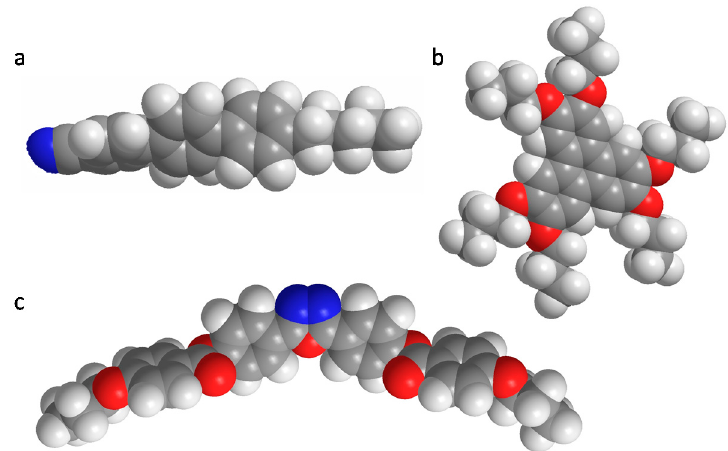
Figure 1. Spacing-filling models of archetypical mesogens: ( a ) rod-shaped terphenyl derivative; ( b ) disc-shaped triphenylene derivative; and ( c ) diphenyloxadiazole-based bent-core mesogen. Note that the aliphatic tails have been shortened for clarity. Atom color coding: black: carbon; white: hydrogen; green: nitrogen; and red: oxygen.